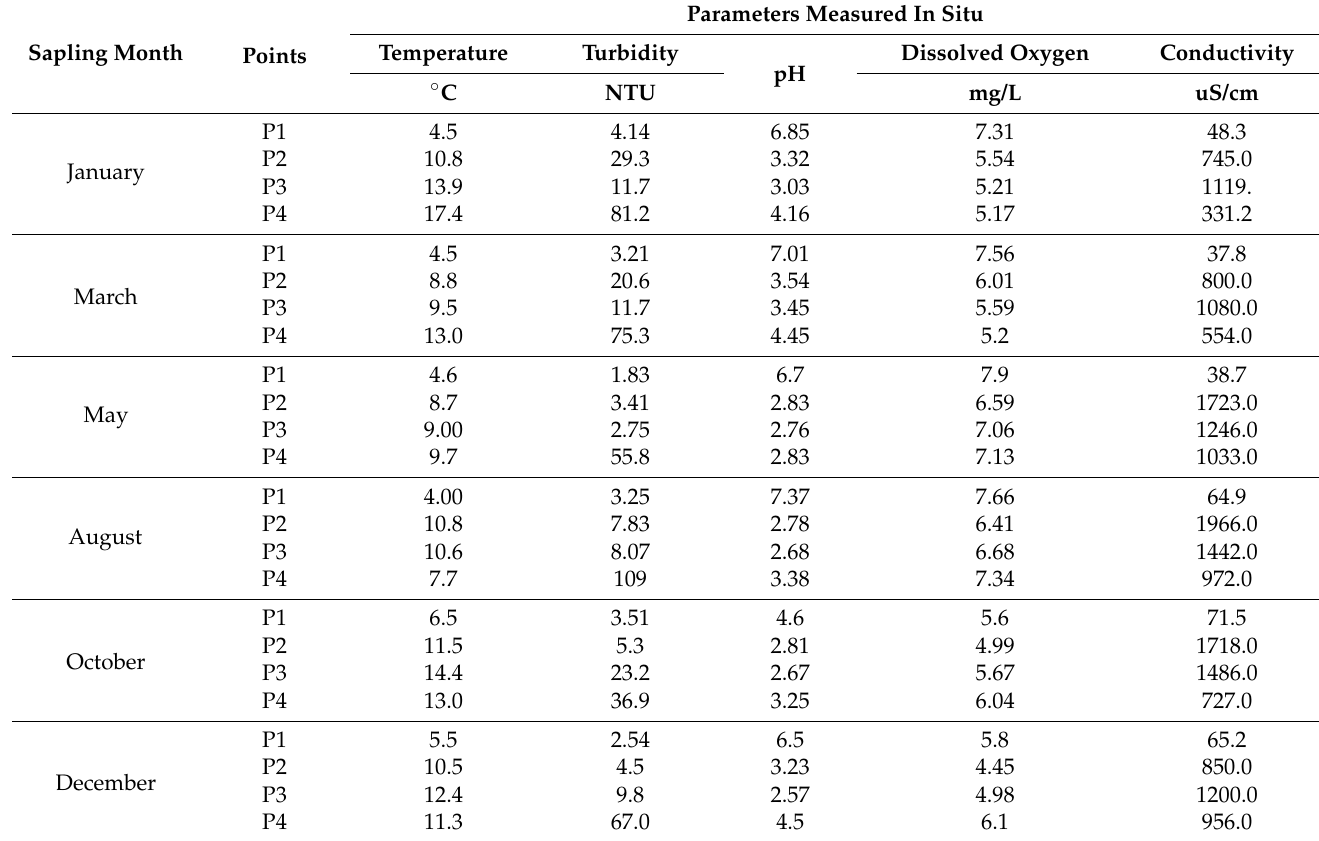
Table 1. Results of the measured in situ